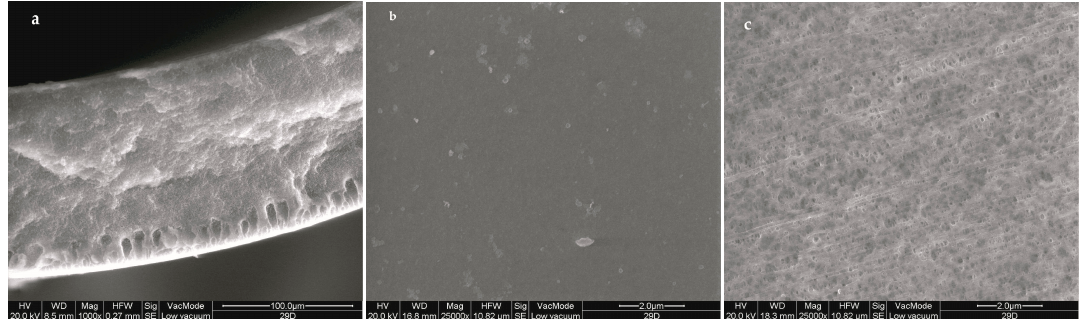
Figure 2. Scanning electron microscopy (SEM) pictures of the cross-section ( a ), the outer ( b ), and inner ( c ) surfaces of hollow fibers.